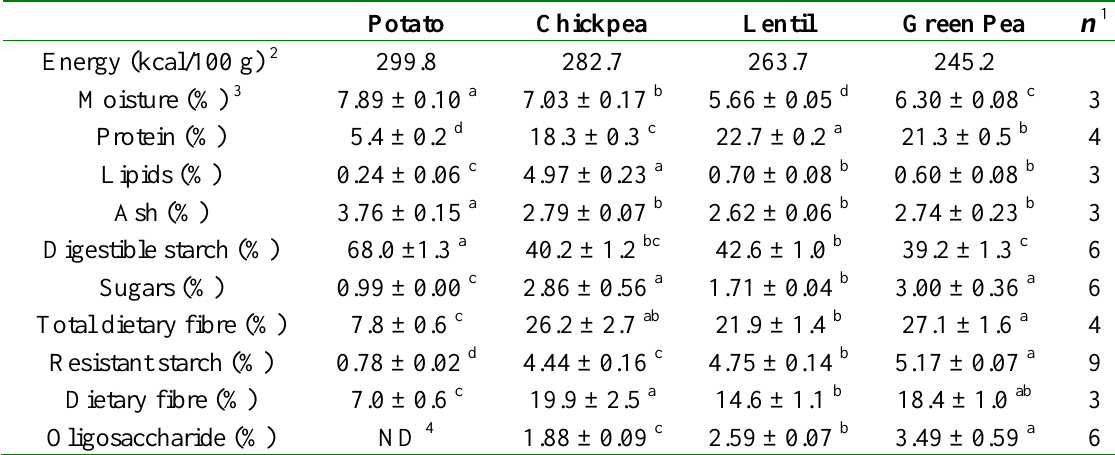
Table 1. Proximate and nutrient composition of dried treatment